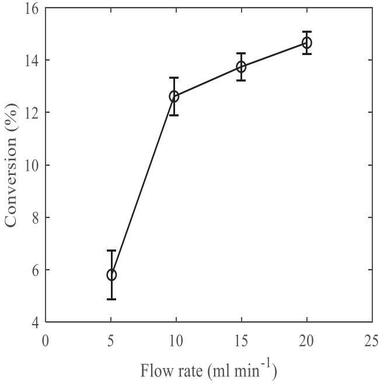
Diagnostic test for external diffusion on the Pt/Al2O3 spheres (Sigma-Aldrich). The flow rate was increased while varying the catalyst weight to maintain a constant ratio of 1.66 kg s mol-1.